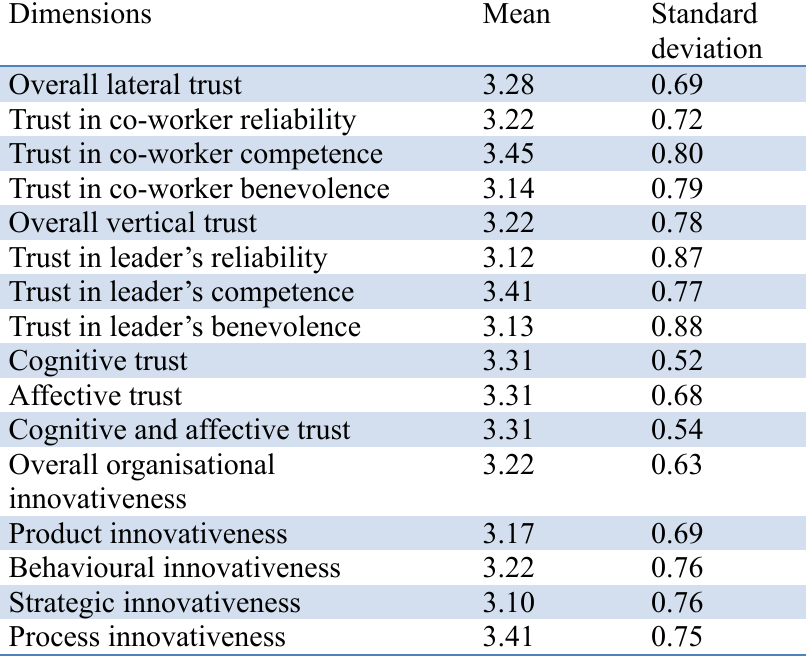
Table A2: Mean and standard deviations for the aggregated dimension scores